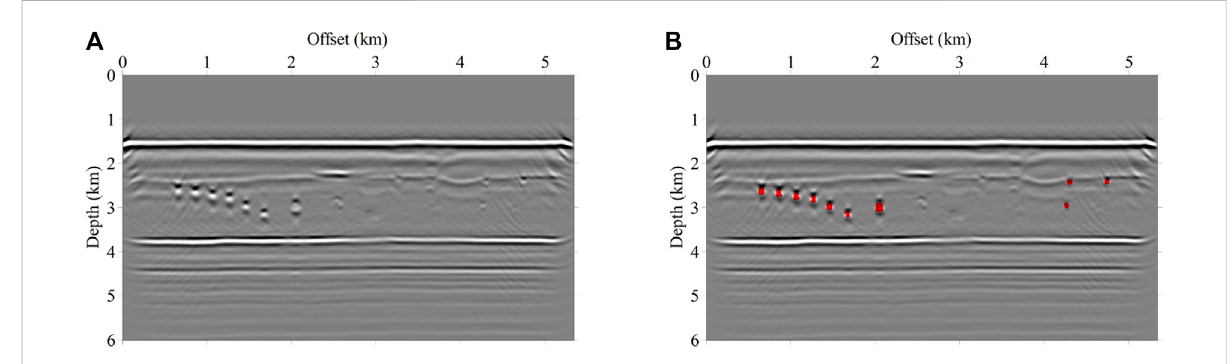
FIGURE 13 The imaging results and prediction results of the physical simulated data on the inline section. (A) is the seismic image, and (B) is the overlaid display of (A) and the predicted